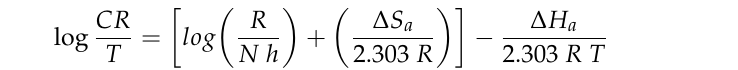
Figure 6. Log CR/T versus (1,000/T) for 316L stainless steel in 0.1 wt.% and in 1.0 wt.% CNTs–water Figure 5. Log corrosion rate (log CR) versus (1,000/T) for 316L stainless steel in 0.1 wt.% and in 1.0 wt.% nanofluids. CNTs–water nanofluids .